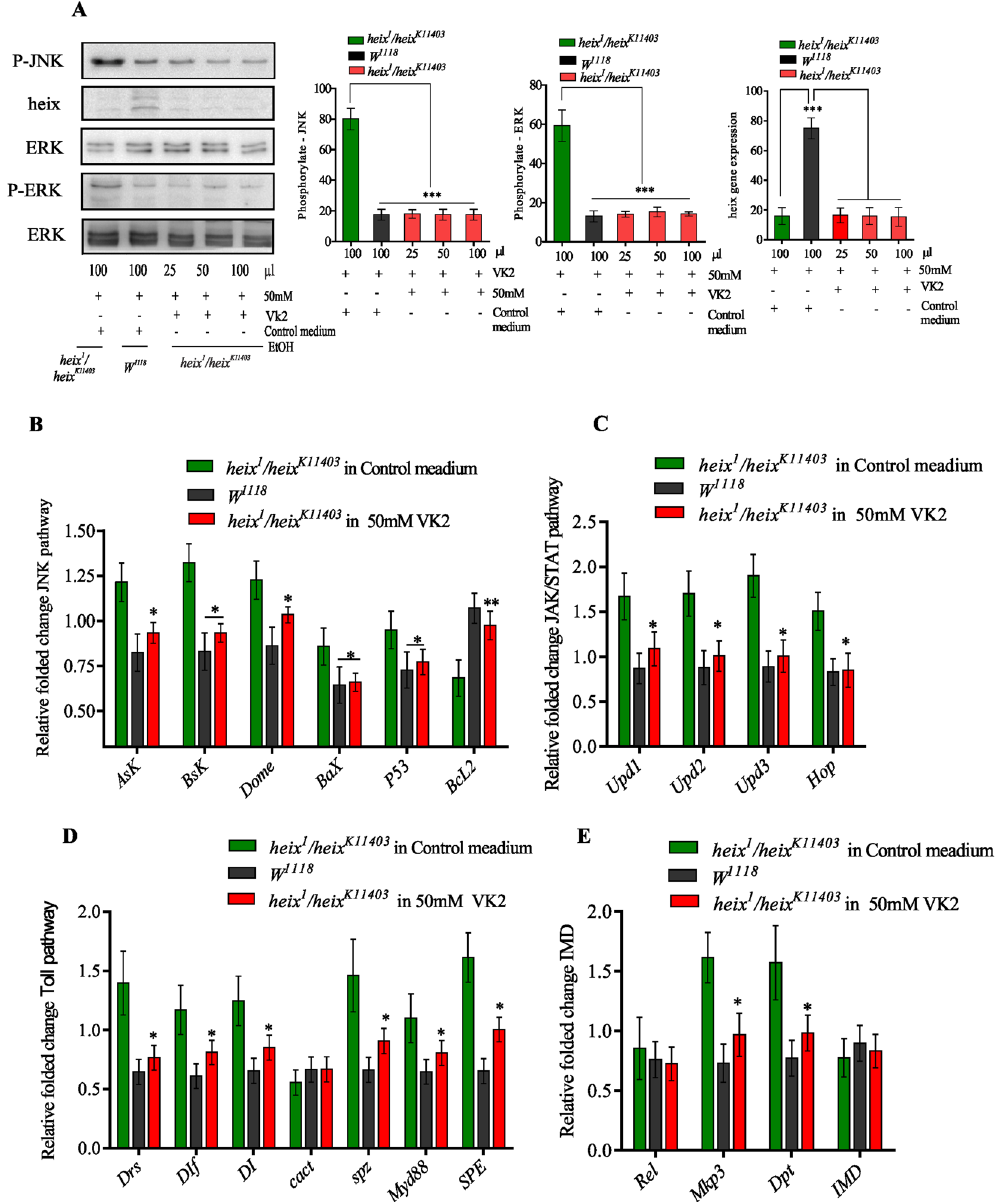
Figure 4. VK2 is negative regulator of Ras/MAPK (JNK, ERK) and Toll, JAK/STAT, IMD pathways. ( A ) Western blot analysis showed activation of JNK and ERK signaling pathways upon loss of function of heix gene and inhibition of activation significantly revealed after vitamin K2 treatment. ( B ) RT-PCR analysis of JNK pathway. ( C ) RT-PCR analysis of JAK/STAT pathway ( D ) RT-PCR analysis of Toll pathway. ( E ) RT-PCR analysis of IMD and Ras/MAPK pathway. Control media contain 50 mM Ethanol (EtOH) and treatment media contain 50 mM VK2. Transcripts were normalized to the housekeeping gene Ef1 α 100E . Error bars indicate SEM. A significant difference is compared to the control (AVOVA/Dunnett: * P < 0.05, ** P < 0.01, *** P <